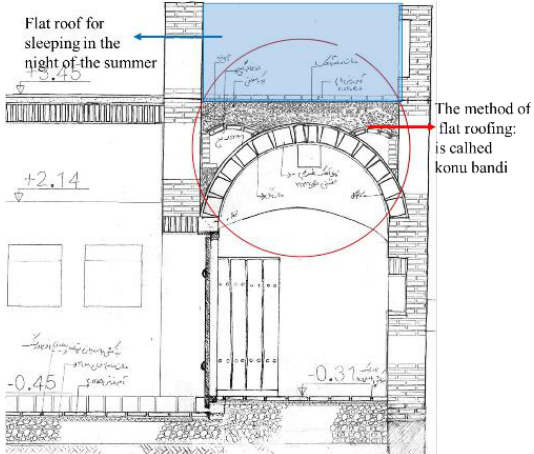
Figure 18. The flat roof and the method of flat